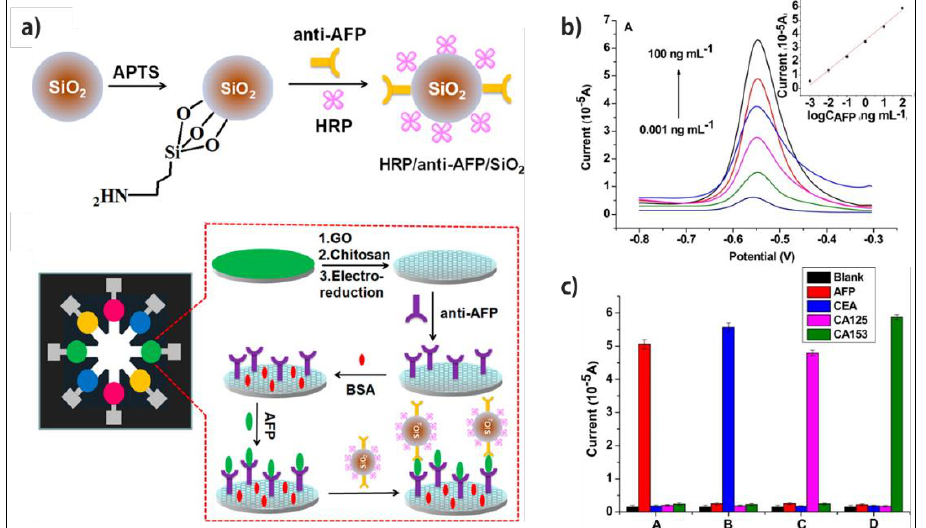
Figure 5. ( a ) Schematic illustration of fabrication of microfluidic paper-based analytical device ( µ PAD) for multiplex quantification of four cancer biomarkers; ( b ) Performance and the corresponding linear calibration curve of one platform toward di ff erent concentrations of AFP from 0.001 ng · mL − 1 to 100 ng · mL − 1 ; ( c ) electrocatalytic behavior of each platforms of ( A ) anti-AFP / rGO, ( B ) anti-CEA / rGO, ( C ) anti-CA125 / rGO, and ( D ) CA153 / rGO upon their matching target antigens of AFP, CEA, CA125, and CA153, respectively. Negligible cross reactivity was observed, showing the great specificity of the device. Reproduced with permission from [84].